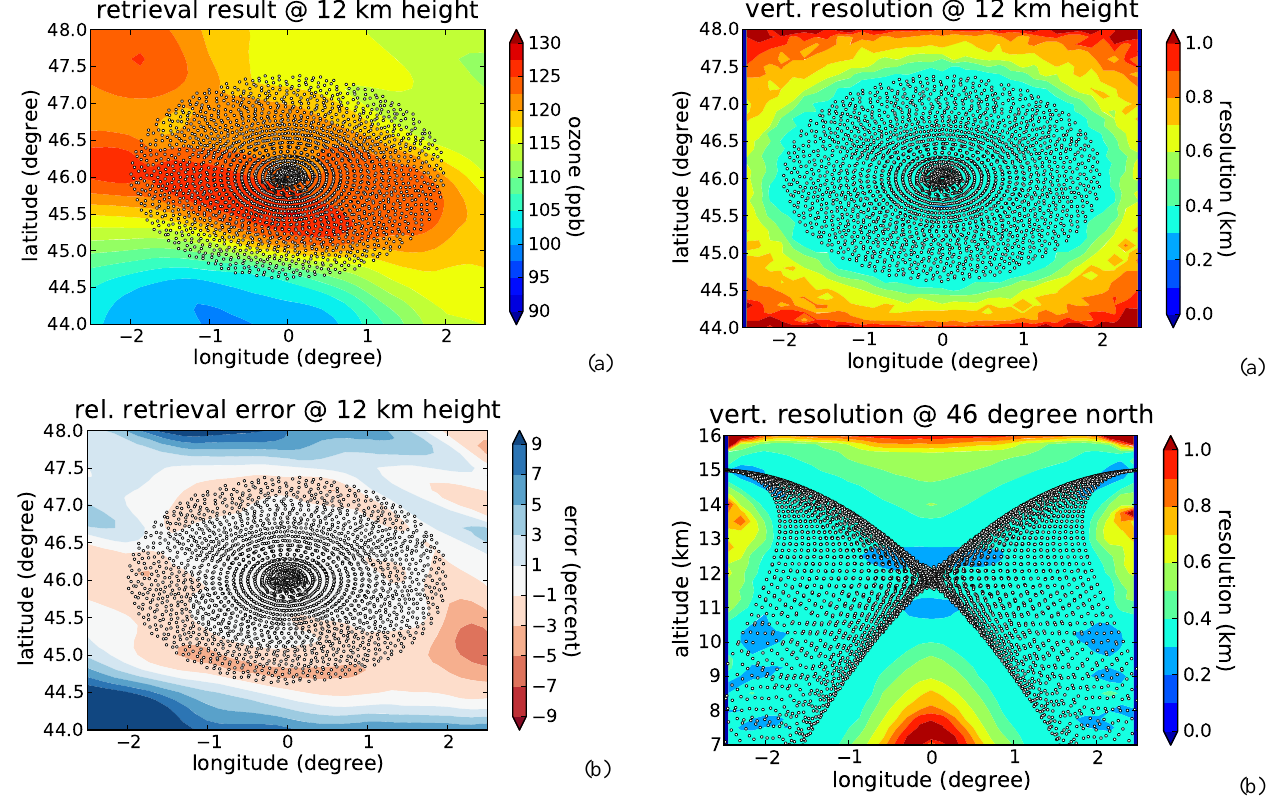
Fig. 7. The vertical resolution of the baseline setup. (a) Shows the vertical resolution at 12km altitude while (b) depicts the vertical resolution at 46 ◦